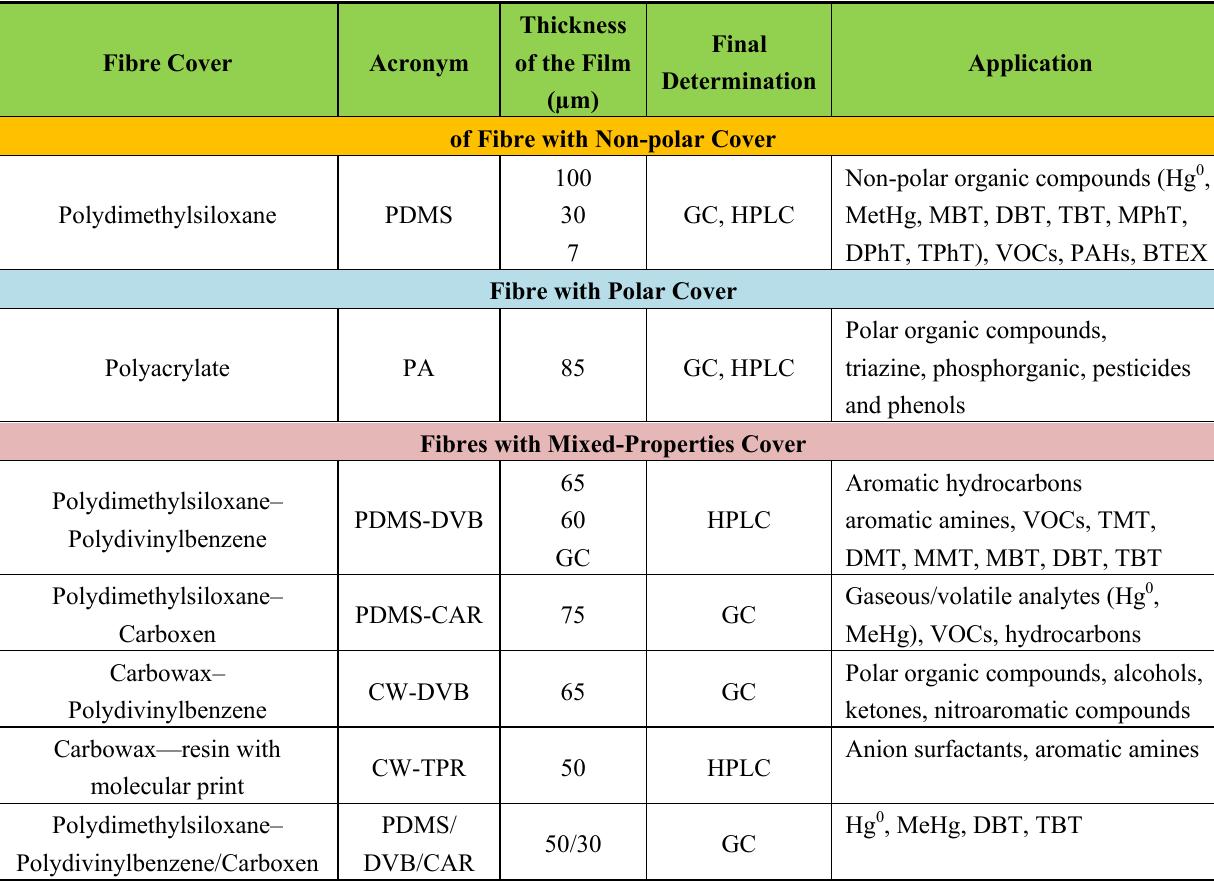
Table 3. Characteristics of extraction fibres for commercially available SPME set [27,29,52,57]. Fibre Cover